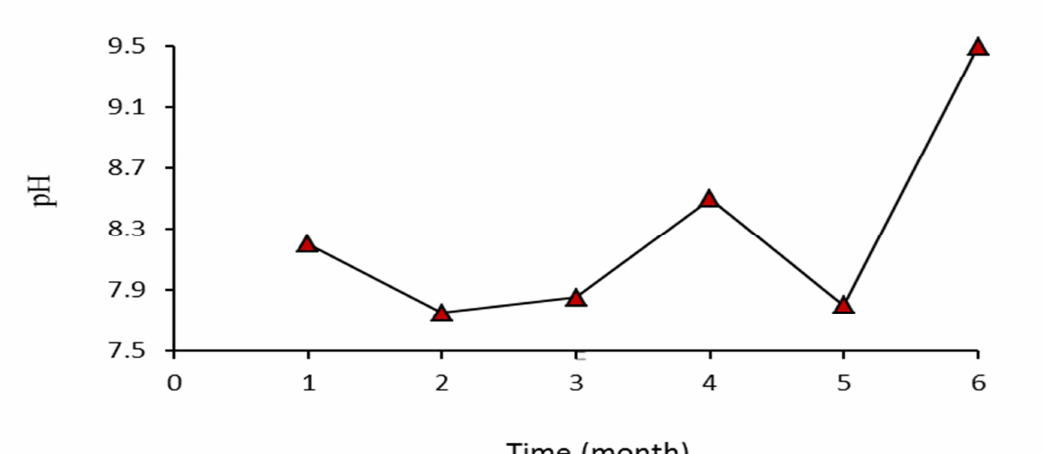
Figure 1. Monthly pH changes trend in effluent from ammonia unit in Razi petrochemical